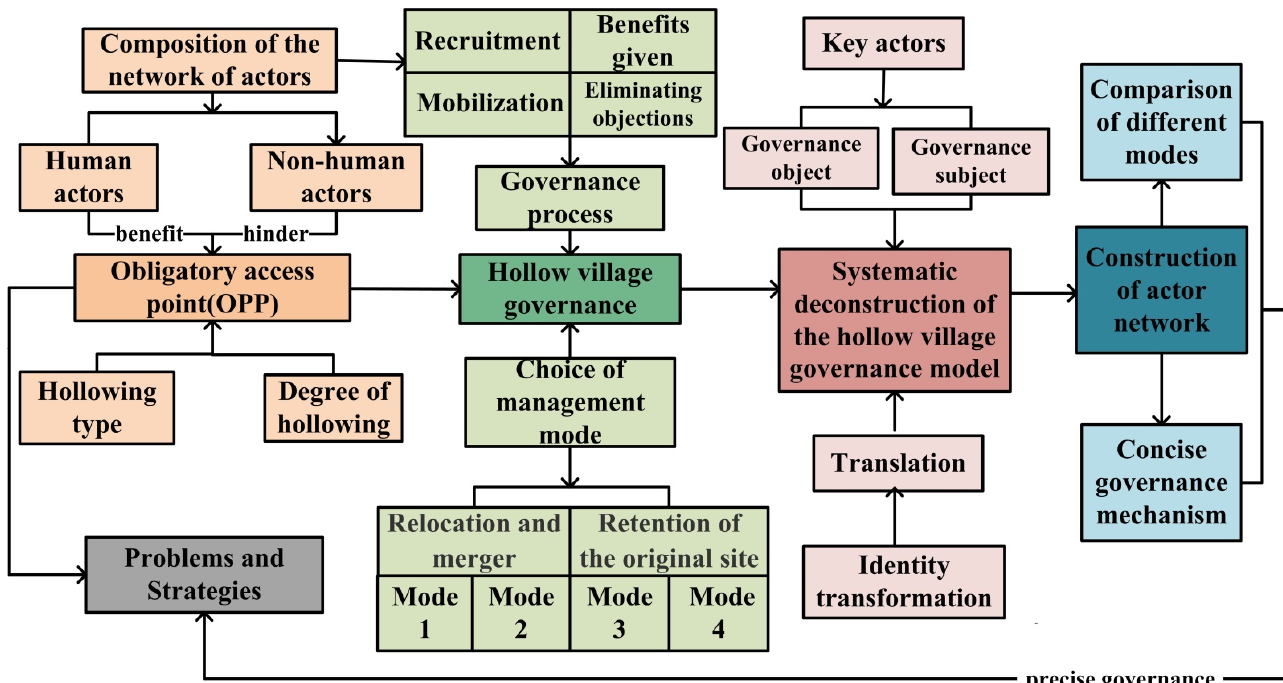
Figure 1. Research ideas of hollow village governance based on actor–network theory.